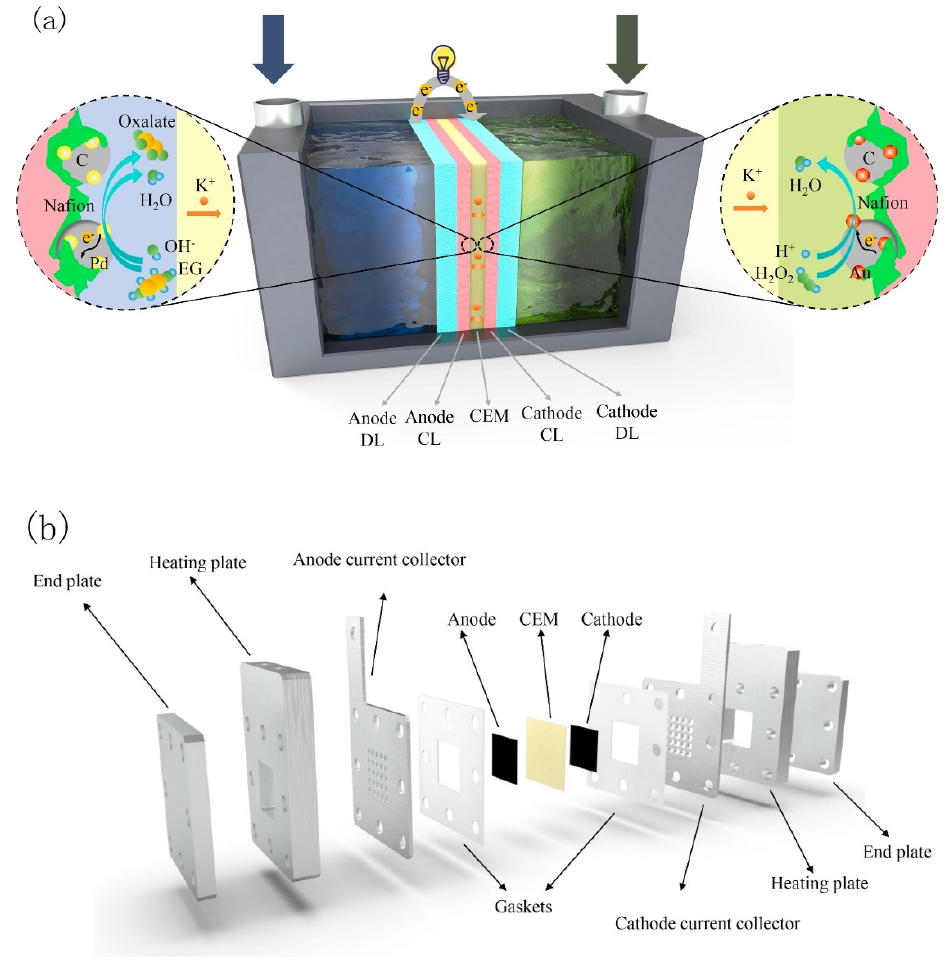
Figure 18. Schematic of AA-based PS-DEGFC: ( a ) working principle; ( b ) exploded view of the structure. Reproduced from [172] with permission from Elsevier 2019.